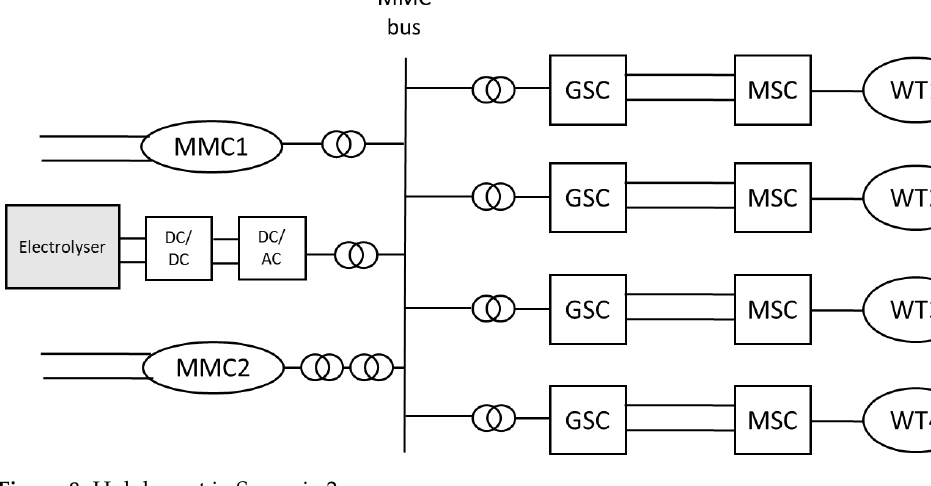
Figure 8. Hub layout in Scenario 2.